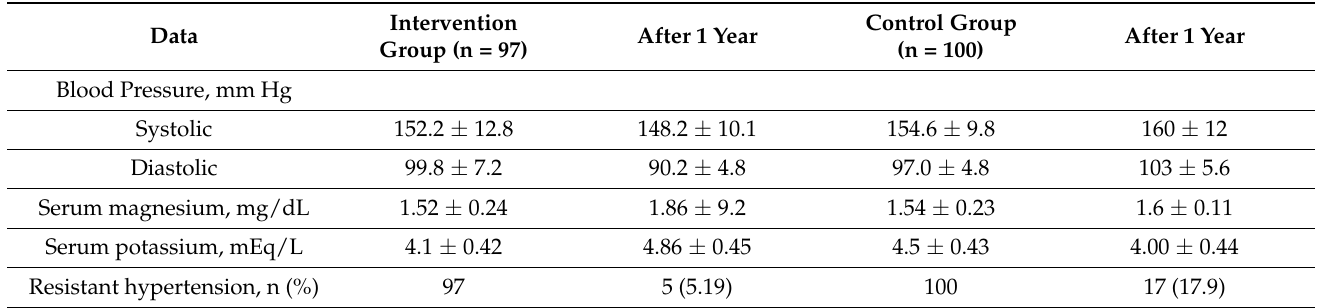
Table 1. Effects of Indo- Mediterranean foods; fruits, vegetables and legumes on blood pressures in patients receiving thiazide diuretics. (Modified from Singh et al.